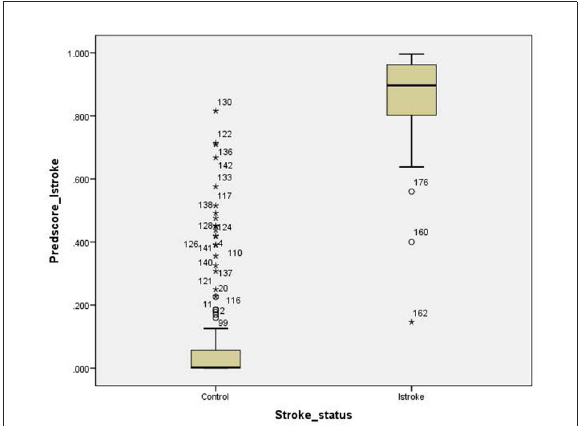
FIGURE4 Box plot for the probability of ischemic stroke.